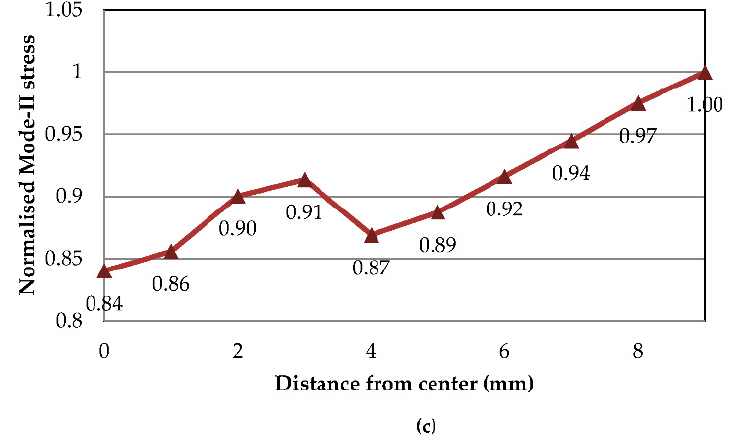
Figure 10. Normalised Mode-II stress distribution along crack tip at ( a ) 30, ( b ) 70 and ( c ) 110 °C.